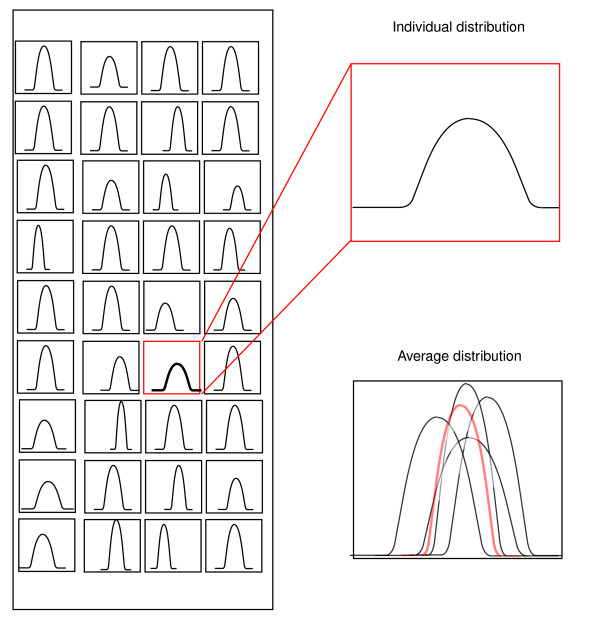
Scheme for the signal scaling method. The signal of one spot on the array is normalized according to the distribution in its local neighborhood. For each spot, a surrounding window is chosen and all spots in this window are defined as its neighborhood. The signal of a center spot will then be normalized by comparing the local median and MAD with the average values. Norm, normalized signals; Origin, original signals.